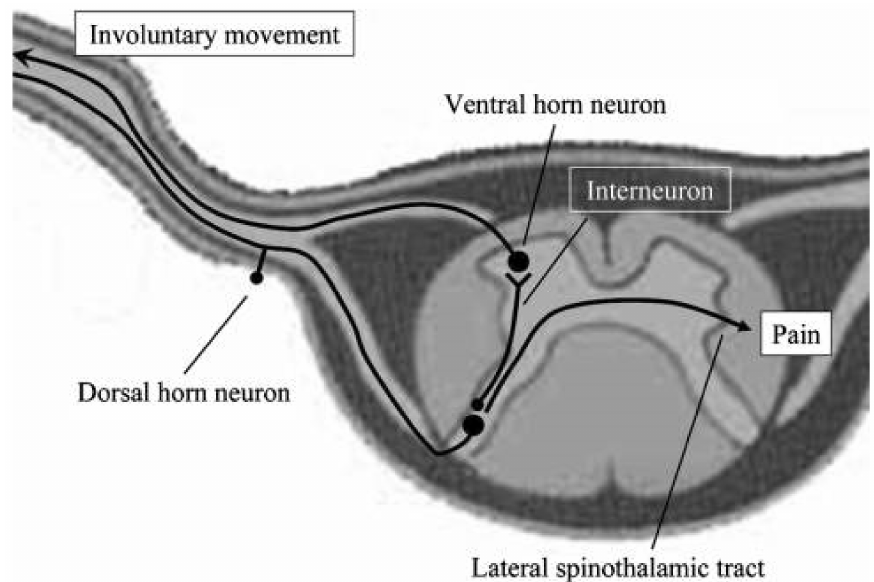
Figure 1. Theory of the interneuron role in the development of pain and involuntary movement of PLMT (reproduced from [40] under the © The Association of Bone and Joint Surgeons ® 2010